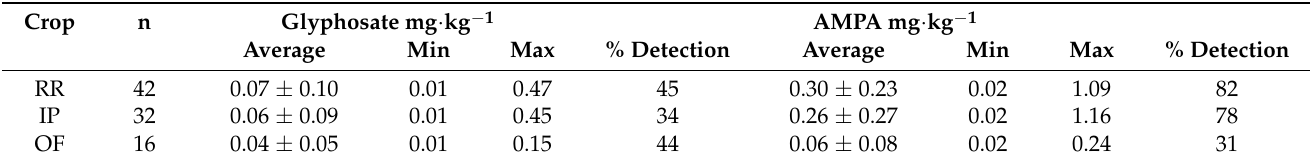
Table 3. Measured glyphosate and AMPA content in agricultural soils of the study for Roundup Ready (RR), Identity Preserved (IP) and Organic Farming (OF) cropping